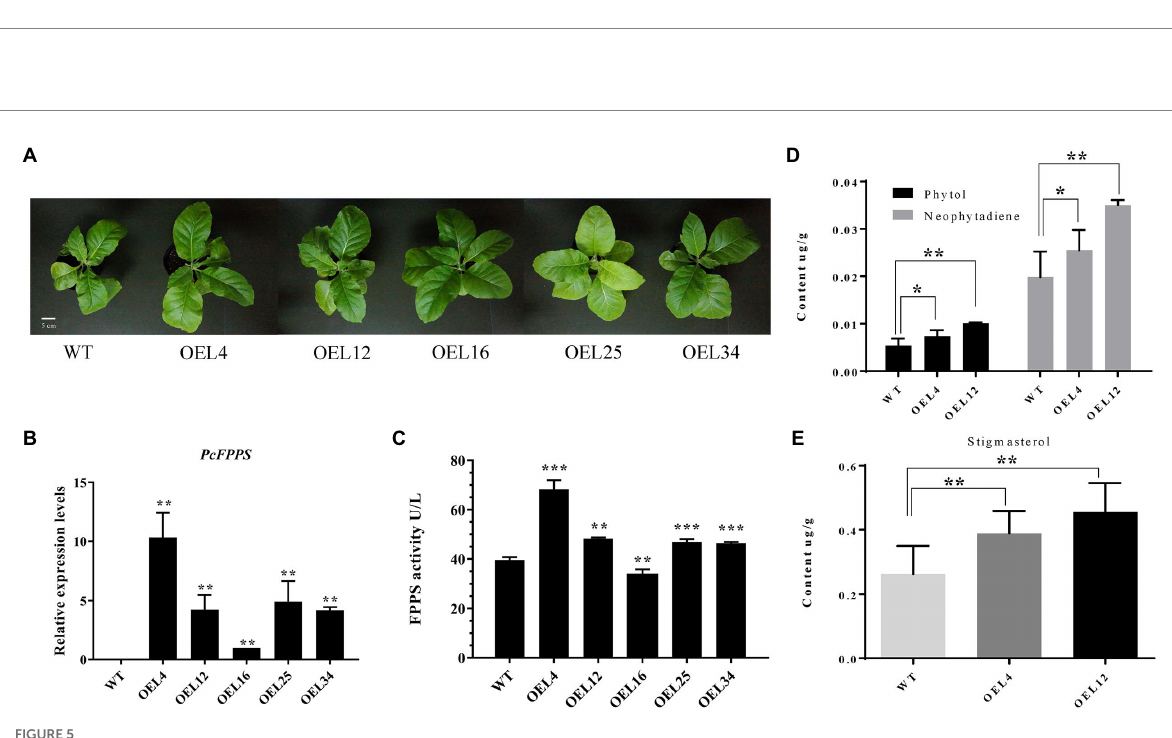
FIGURE 4 Transient overexpression of PcFPPS increases the accumulation of patchouli alcohol in P. cablin leaves . (A) The coding region without stop codon of PcFPPS was cloned into the pCAMBIA1304 vector controlled by the 35S promoter to form the pCAMBIA1304- PcFPPS . (B) Patchouli alcohol contents in leaves of CK (wild type), the empty vector pCAMBIA1304, and transformations pCAMBIA1304- PcFPPS . (C) Gas Chromatography–Mass Spectrometer (GC-MS) chromatograms of samples from the pCAMBIA1304- PcFPPS (top panel), pCAMBIA1304 (middle panel), and CK (bottom panel) leaves showing abundance of patchouli alcohol. Data represent the mean ± SEs of three biological replicates. The asterisks represent significant differences, as indicated by t -test (** p < 0.01). FW, fresh weight.